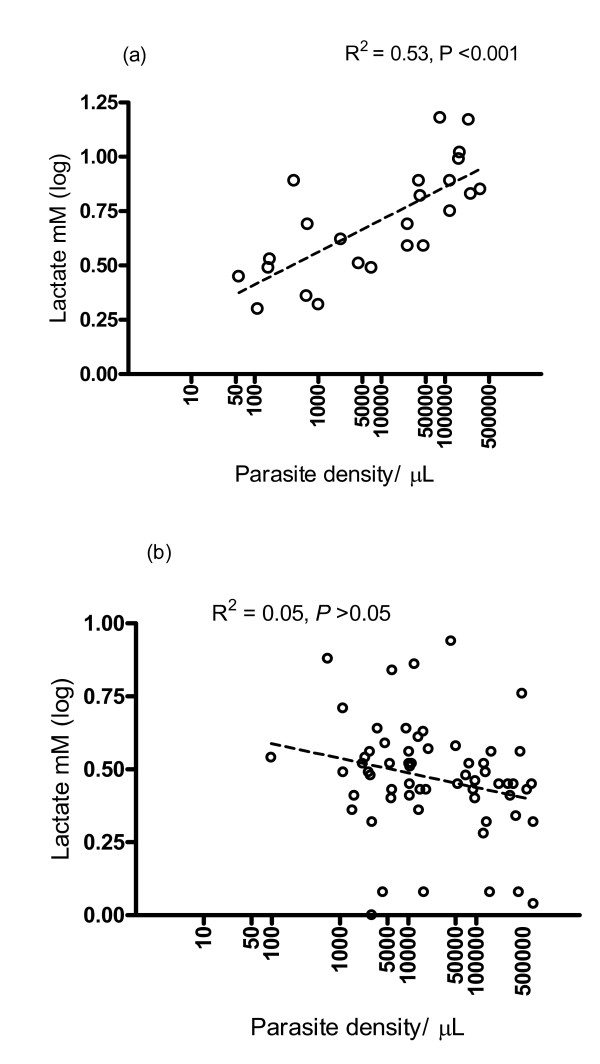
Plasma lactate concentration and parasite density in children with acute malaria and severe anaemia (a) and non-severe anaemia (b). Parasite density is plotted on a loge scale. Dotted line represents regression line and R2 is the coefficient of determination.